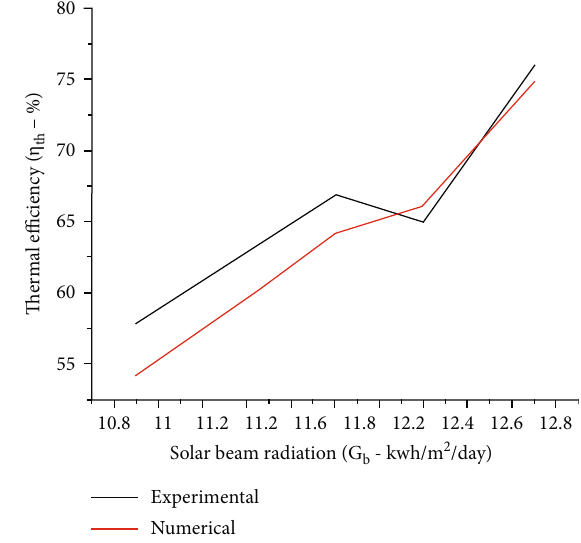
Figure 19: Changes in experimental and numerical values of thermal e ffi ciency with solar beam